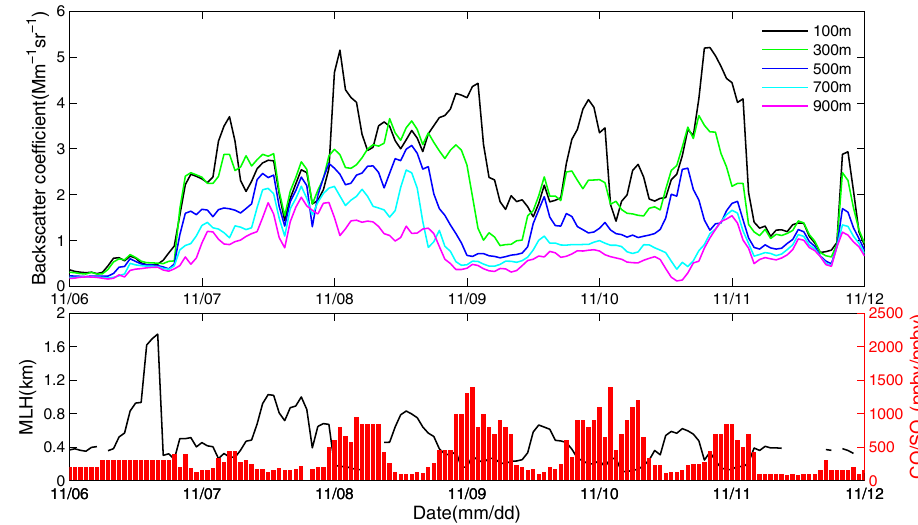
Figure 11. Attenuated backscattering coefficients at different heights and near-surface CO / SO 2 ratios from 6 to 11 November.